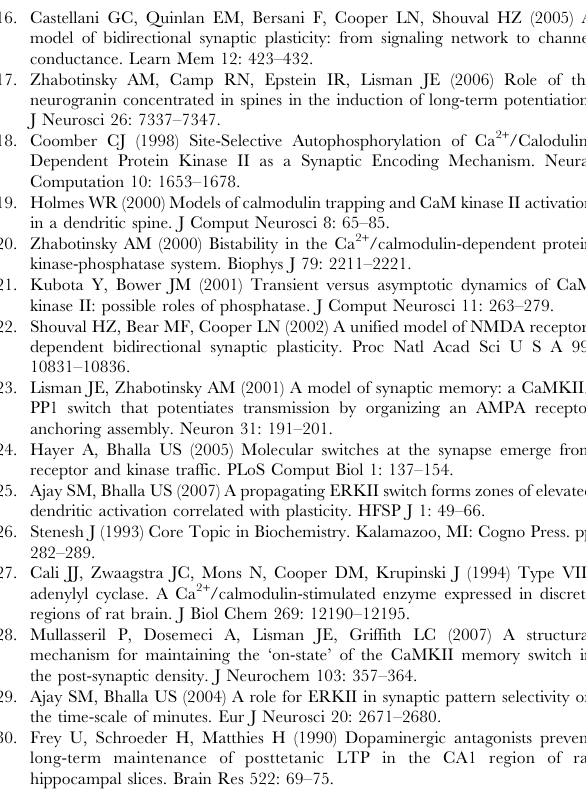
persistence of CaMKII phosphorylation. (A) Transient phosphoCaM- allowing protein phosphatase 1 to dephosphorylate the calmodulin bound form of phosphoCaMKII. The decrease in CaMKII phosphorylation is very small when PKA activity is blocked, suggesting the importance of spatial mechanisms or saturated holoenzyme activity for enhancing the effect of PKA. (B) Using this more transient curve (instead of peak). Cumulative activity of phosphoCaMKII decreases with increasing inter-train interval and cumulative activity for PKA increases with increasing inter-train interval. Figure S3 Results are robust to variation in parameters. (A) Variation of PKA enzyme quantity: both basal and peak PKA activity varied but spaced stimulation produces , 60% more total activity than massed. (B) Effect of protein phosphatase 1 enzyme